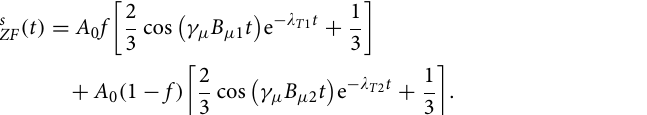
Figure 4. ( a ) The time dependence of the muon asymmetry in BMTO in a transverse field B TF various temperatures (symbols). The solid lines are fits with the model (3) for t > 0.3 µ s. ( b ) The relative amplitude of the signal oscillating with the frequency γ µ B TF /( 2 π) corresponding to the fraction of muons not detecting static internal fields of electronic origin in BMTO. The inset shows the temperature dependence of the transverse muon relaxation rate of the oscillating signal. The vertical dashed line shows the position of T N Muon spin relaxation ( µ SR). Transverse field (TF) µ SR measurements are a very efficient probe of mag-